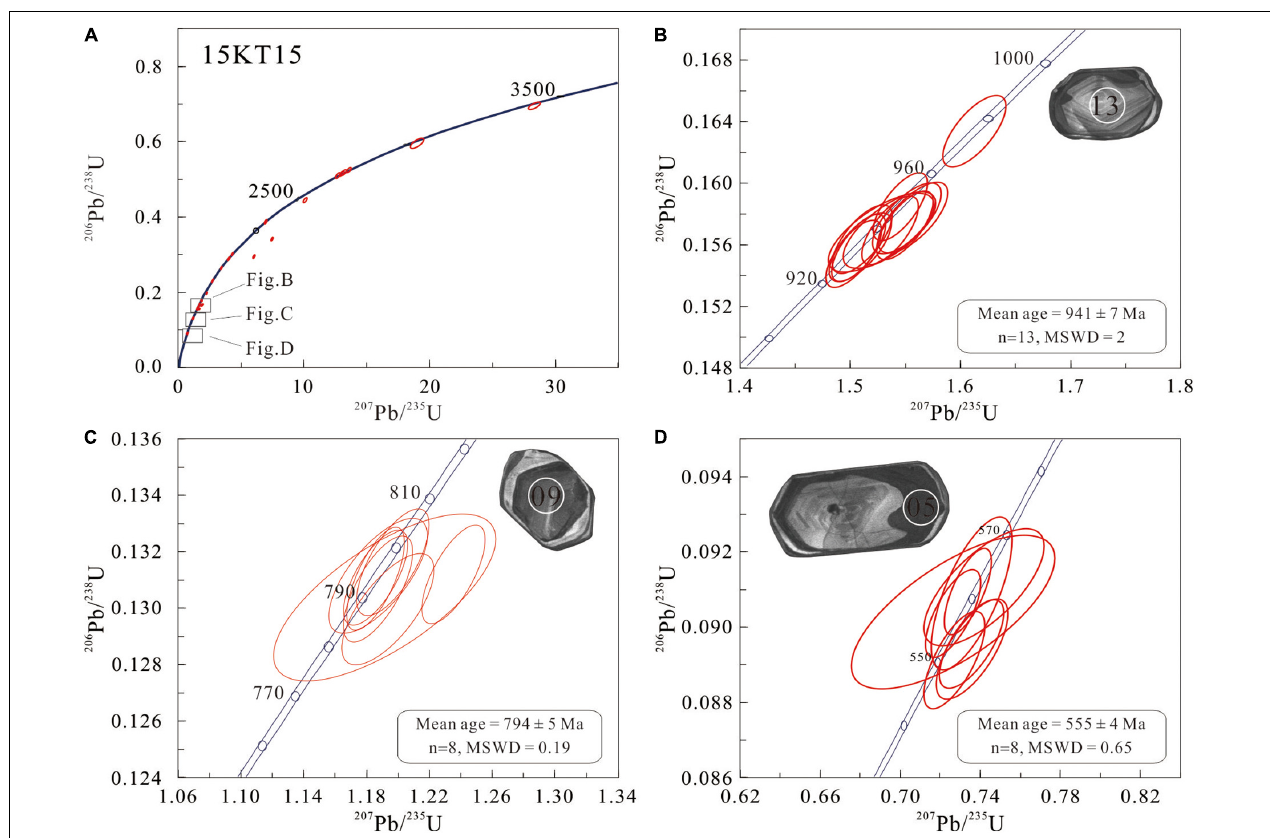
FIGURE 5 | U–Pb age Concordia plots for sample 15KT15. (B–D) are enlargements of (A) . Typical zircon cathodoluminescence (CL) images are also shown (the circle for LA-ICPMS dating is 30 µ m).